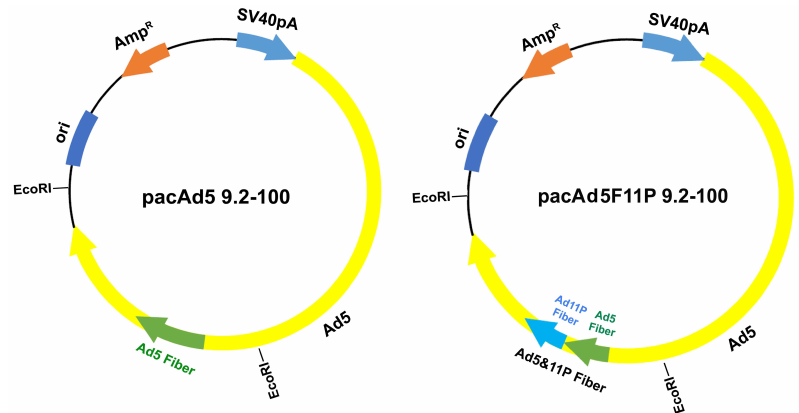
Figure 1. Modifications of the adenoviral backbone vector pacAd5 9.2-100. The proviral gene of units 9.2-100 of the Ad5 and chimeric fiber Ad are diagramed. The chimeric Ad5 and Ad11P fiber gene is indicated.